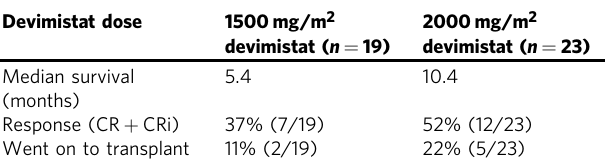
Table 2 Responses 60 years of age and